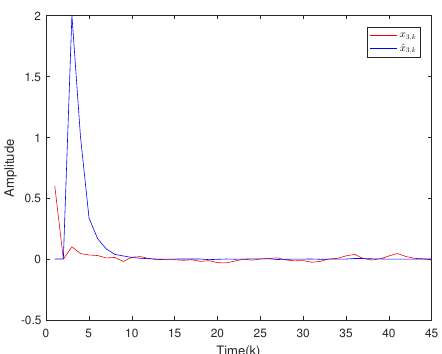
Figure 4. The state evolutions of x 3, k and corresponding estimates ˆ x 3, k .